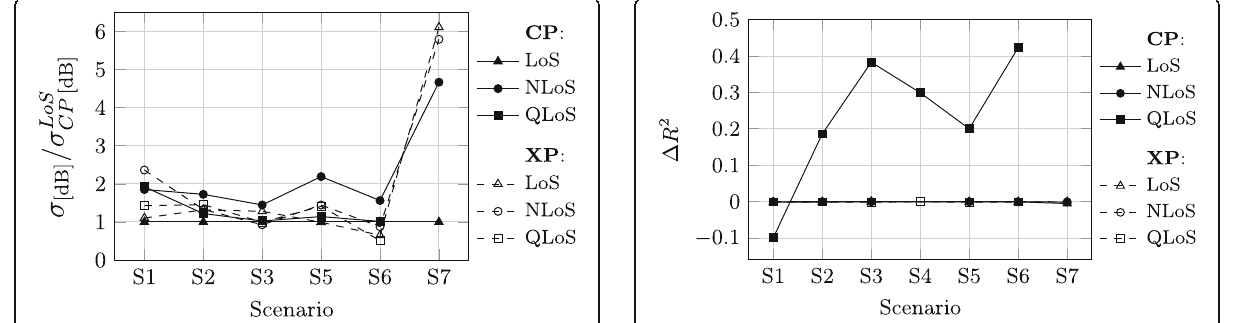
Fig. 5 Normalised standard deviation of the signal